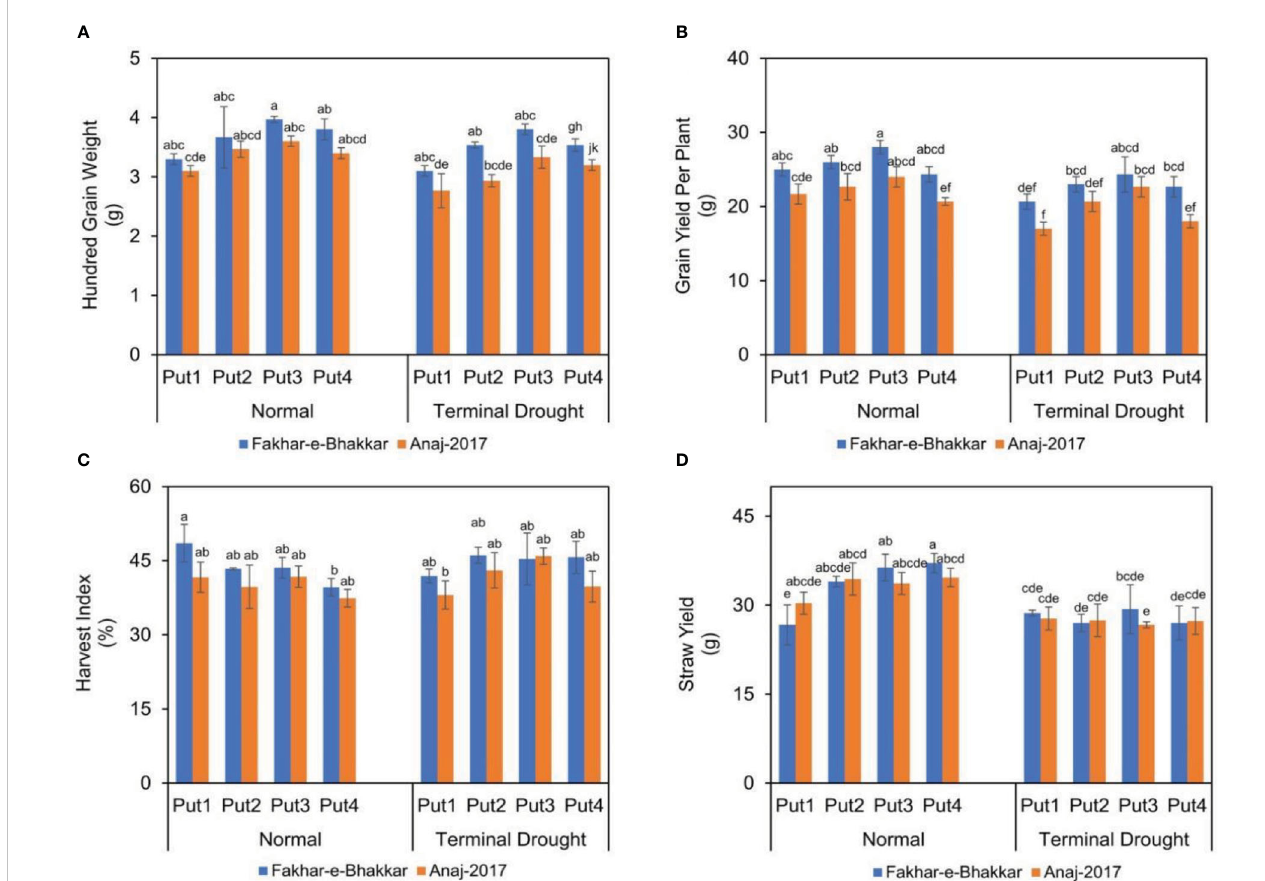
FIGURE 5 The effect of putrescine on the 100-grain weight (A) , grain yield (B) , harvest index (C) , and straw yield (D) of two wheat cultivars under normal and terminal drought conditions. Abbreviation: PPM, parts per million, Put1, putrescine 0 PPM (untreated control); Put2, putrescine 0.5 PPM; Put3, putrescine 1.0 PPM; Put4, putrescine 1.5 PPM. The different letters above the bar columns indicate signi fi cant differences in mean ± SE at p< 0.05. At least three independent biological replications were considered for each